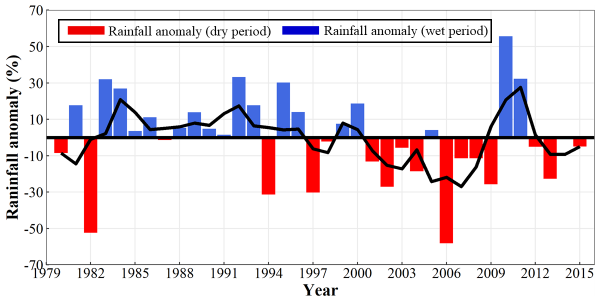
Figure 2. Rainfall anomaly (%) as a percentage of the mean an- nual rainfall of the Kileys Run and Red Hill catchments, New South Wales, Australia. Red bars represent dry years and blue bars repre- sent wet years. The black line represents the 3-year moving average of the rainfall